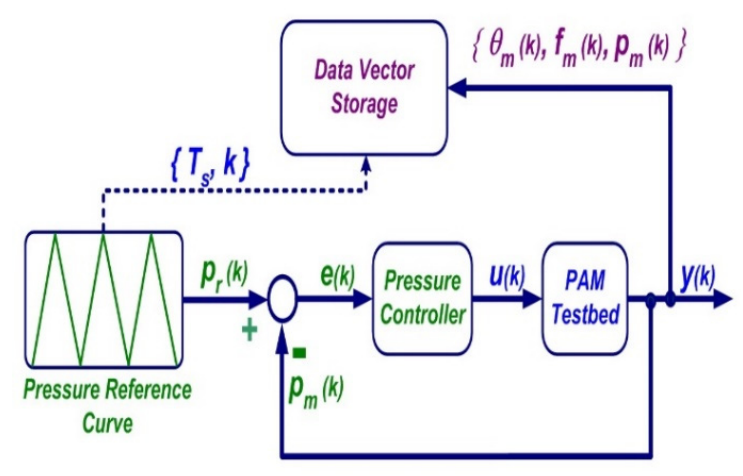
Figure 4. Block diagram of data acquisition setup.